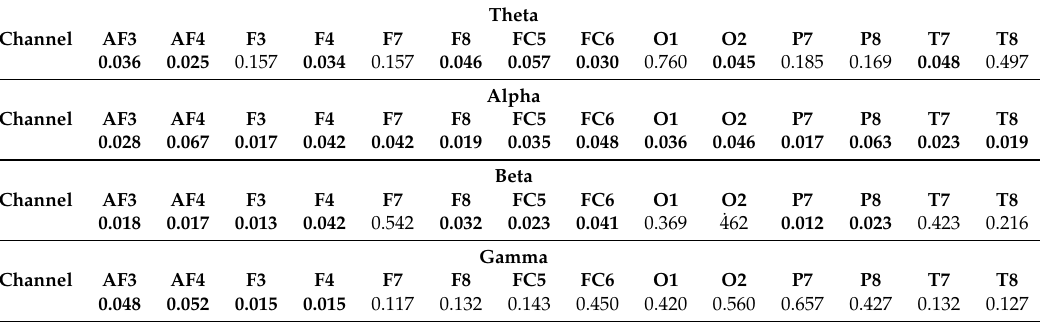
Table 3. p -value from Mann-Whitney test in all participants for segments of 15